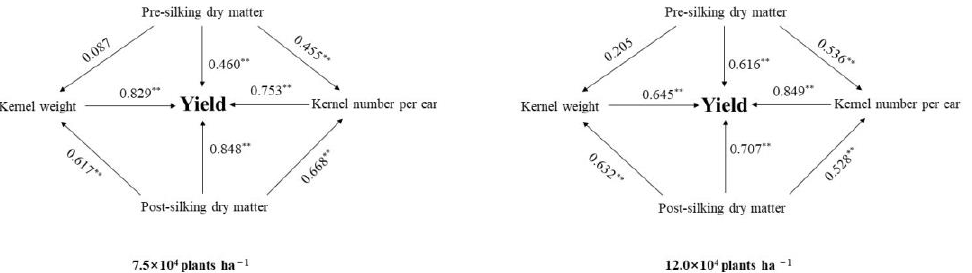
Figure 4. Correlation between yield, kernel weight, kernel number per ear, and dry matter accumulation before and after silking under different densities. ** represent significant levels of and p = 0.01.